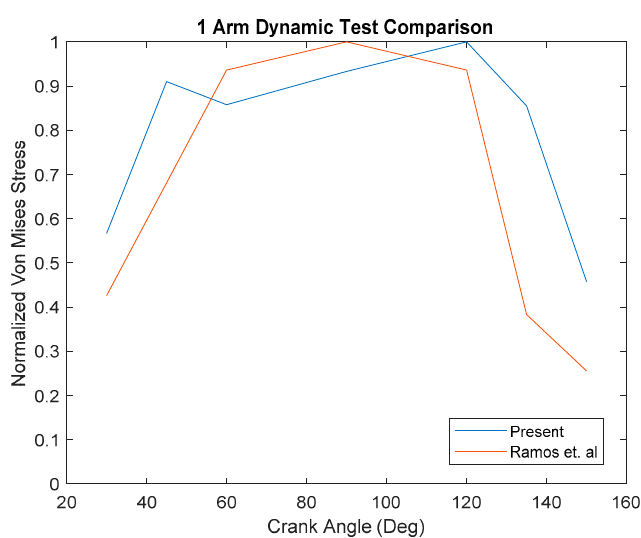
Figure 24 . Normalized Von Mises stress comparison to Ramos et al. [32].